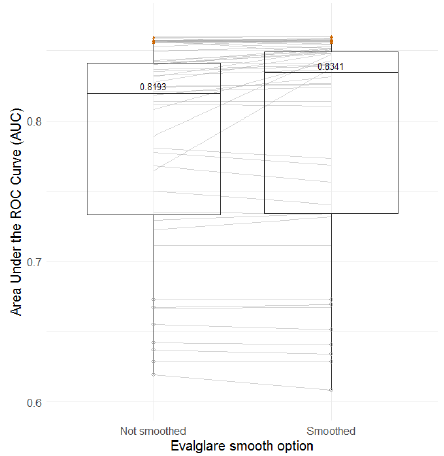
Figure 35. Boxplots of AUC for the non-smooth/smooth parameter (laboratory study).